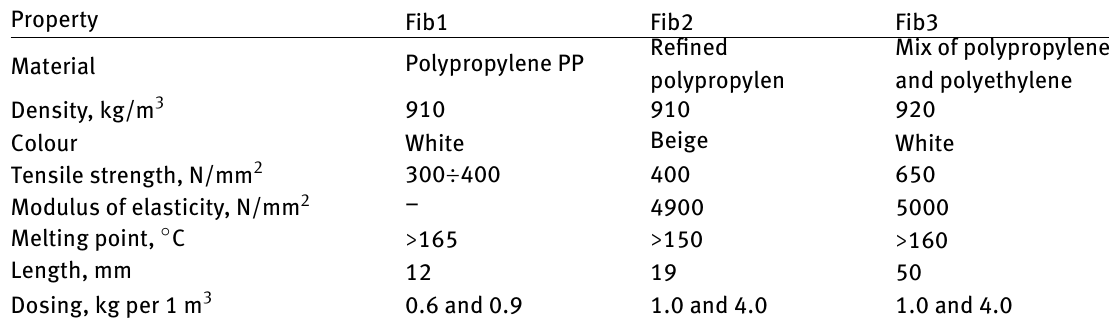
Refined Mix of polypropylene polypropylen and polyethylene